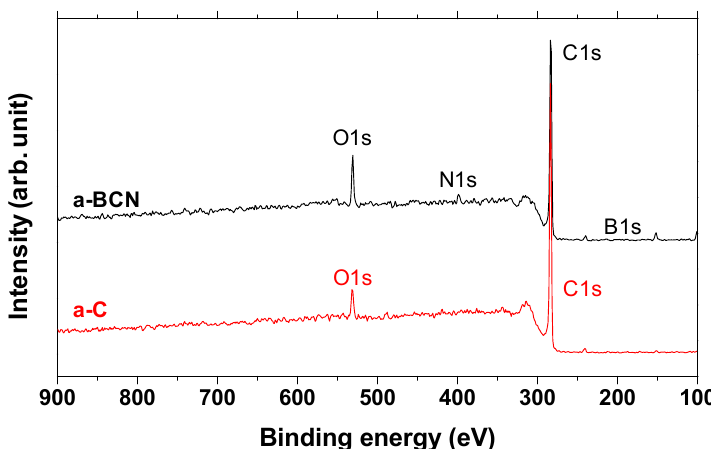
Figure 14. Schematic diagram of the wear behavior during sliding of ( a ) a-C film and ( b ) a-BCN film. Finally, XPS studies were carried out to confirm the formation of boric acid. Figure 15 shows the X-ray photoelectron spectra of the a-C and a-BCN films. Two types of relatively large peaks of C 1s and O 1s and small peaks of N 1s and B 1s are detected for the a-BCN film. The O 1s peak of a-BCN is sharper than that of a-C, indicating that the former contains more oxygen. The origin of the O 1s signal for the a-C sample is attributed to the contamination of the film after exposure to the atmosphere. Figure 16 shows the results of peak fitting of the B 1s, C 1s, N 1s, and O 1s spectra of the a-BCN film. Each peak was deconvoluted separately [20,22,29–33,60–62]. The O 1s and B 1s spectra of a-BCN confirm the presence of B–O bonds. This suggests the possibility of the presence of a boric acid layer at the sliding interface.